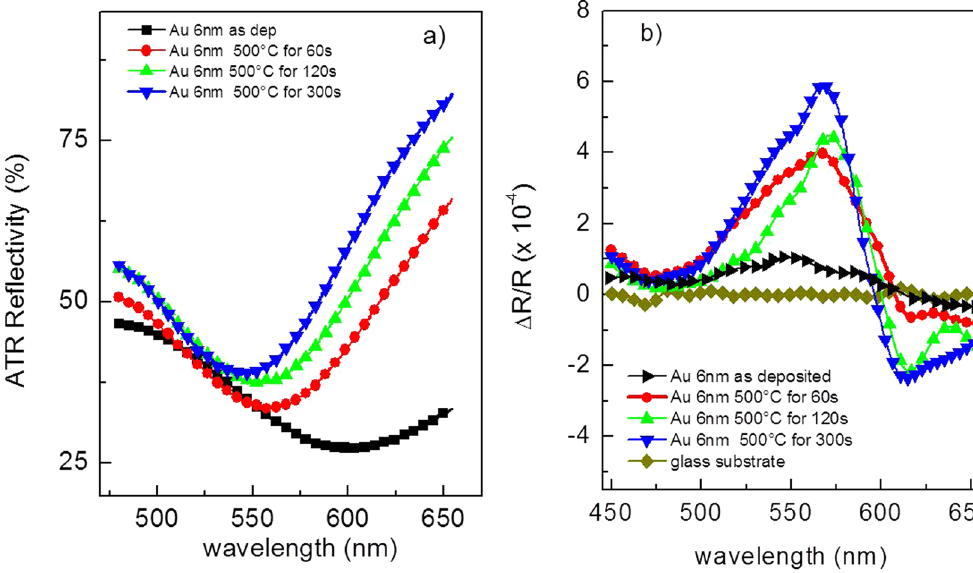
Figure 4. ( a ) Reflectance and ( b ) TMOKE curves recorded both in Kretschmann configuration in the same experimental setup and experimental conditions for the metal nanostructures obtained at increasing annealing